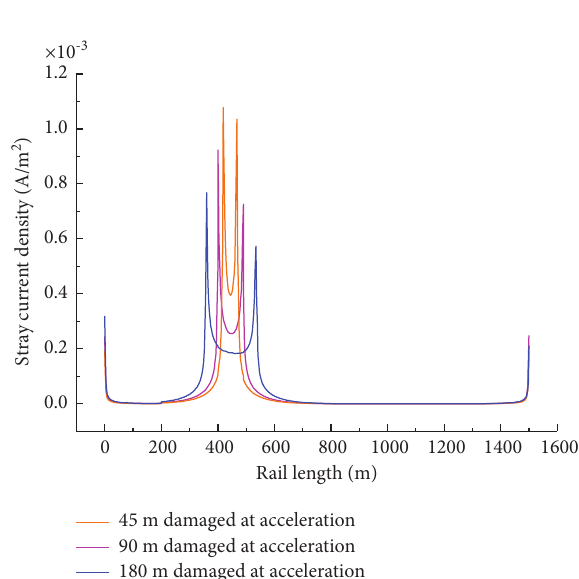
Figure 10: Corrosion current density of rail with different damage